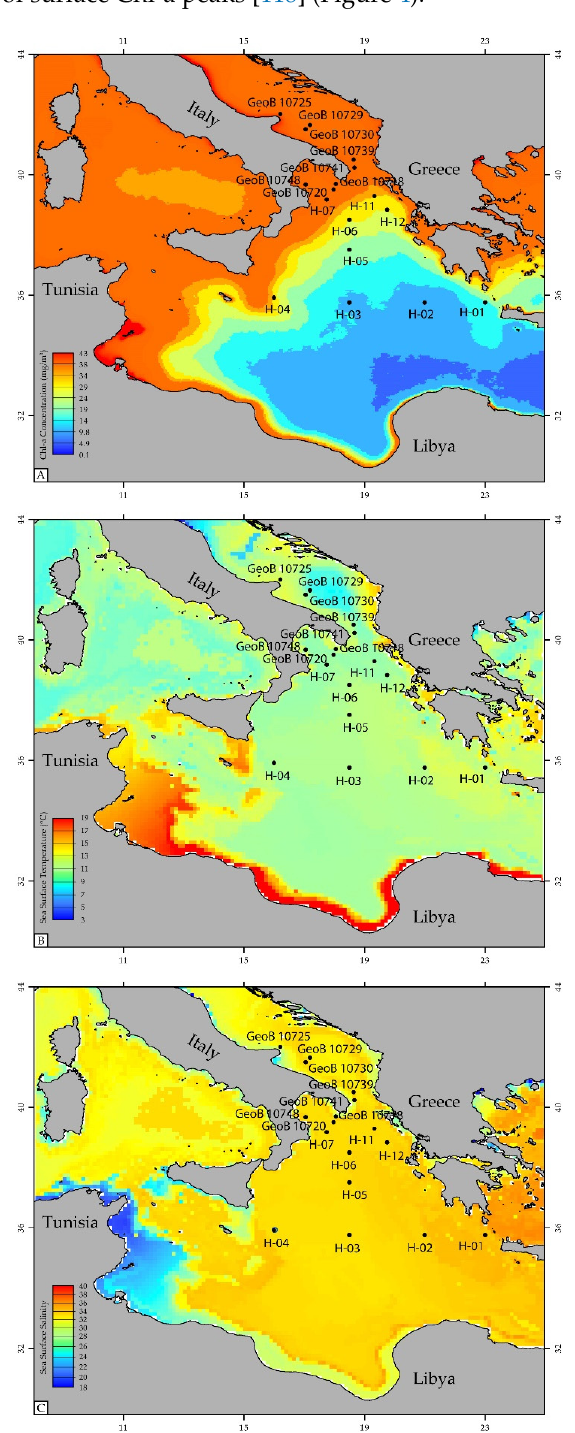
Figure 4. ( A ) Chlorophyll-a (Chl-a), ( B ) sea surface temperature (SST), and ( C ) sea surface salinity (SSS) distribution map for the study area.